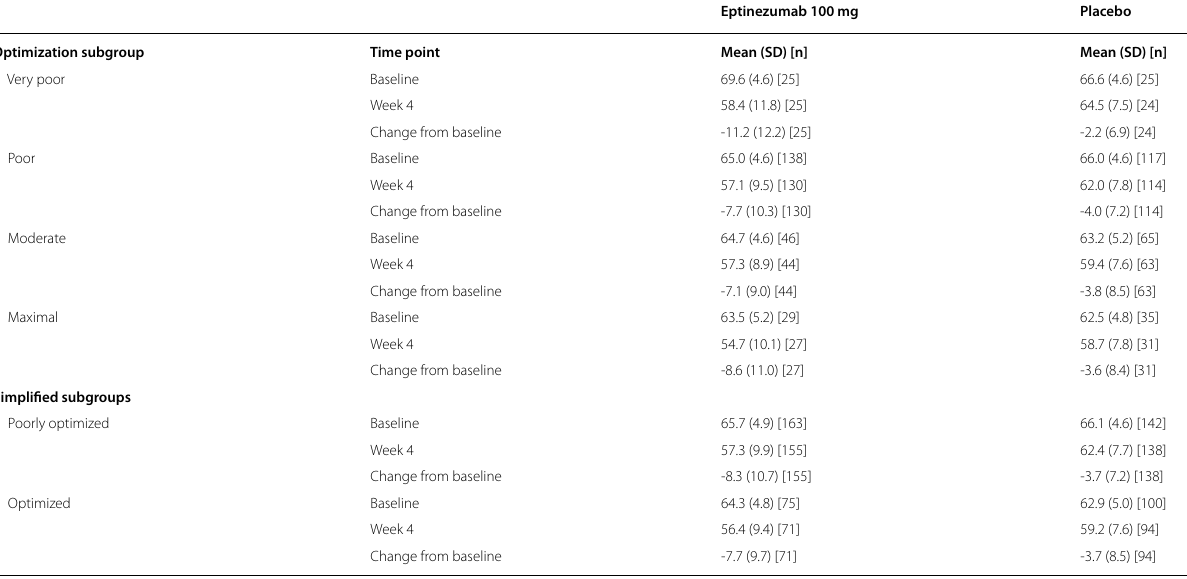
Patients were grouped by baseline mTOQ-4 total scores into the following optimization categories: very poor (0), poor (1–5), moderate (6–7), and maximal (8). The HIT-6 total score ranges from 36 to 78, with higher scores indicating more severe headache-related impact. Simplified subgroups consist of patients with mTOQ-4 total scores in very poor (0) and poor (1–5) categories together, along with patients with total scores in the moderate (6–7) and maximal (8) categories grouped together. Epti, eptinezumab (100 mg); HIT-6, 6-item Headache Impact Test; mTOQ-4, 4-item Migraine Treatment Optimization